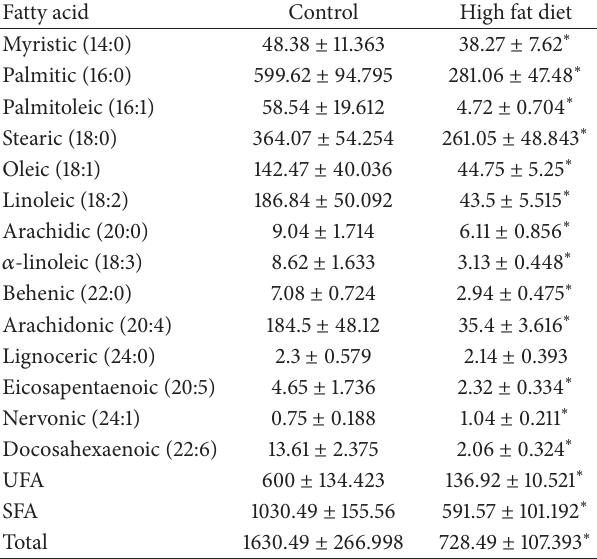
Table 7: Diacylglycerols composition in the submandibular salivary glands (nmol/g).